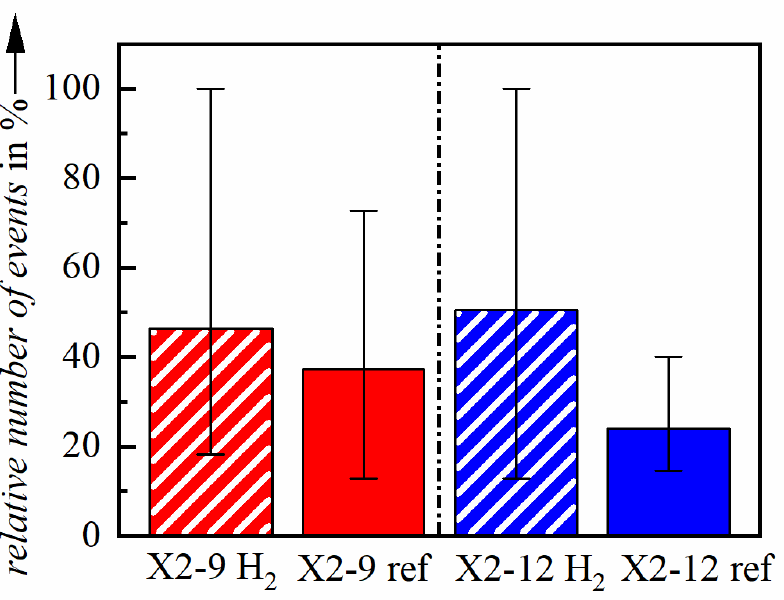
Figure 8. Number of events observed in different material conditions of X2-9 and X2-12, in relation to their respective hydrogen precharged variants.